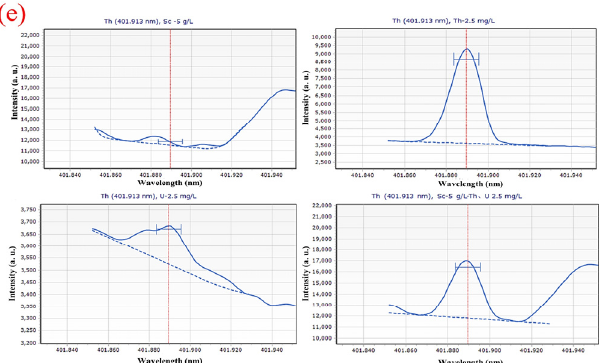
Figure 1. Scanning spectra in di ff erent solution systems (5 g·L − 1 Sc; 2.5 mg·L − 1 Th; 2.5 mg·L − 1 U; 5 g·L − 1 Sc and 2.5 mg·L − 1 Th, 2.5 mg·L − 1 U) at ( a ) 269.242 nm; ( b ) 283.232 nm; ( c ) 283.730 nm; ( d ) 339.203 nm; ( e ) 401.913 nm wavelength. Where the red vertical straight lines represent the wavenumbers of the peaks; the blue dashed lines represent background signal curves; the blue curves represent the signal curve of the sample; and the symbols “H” are target peak position identi fi ers. The same below.